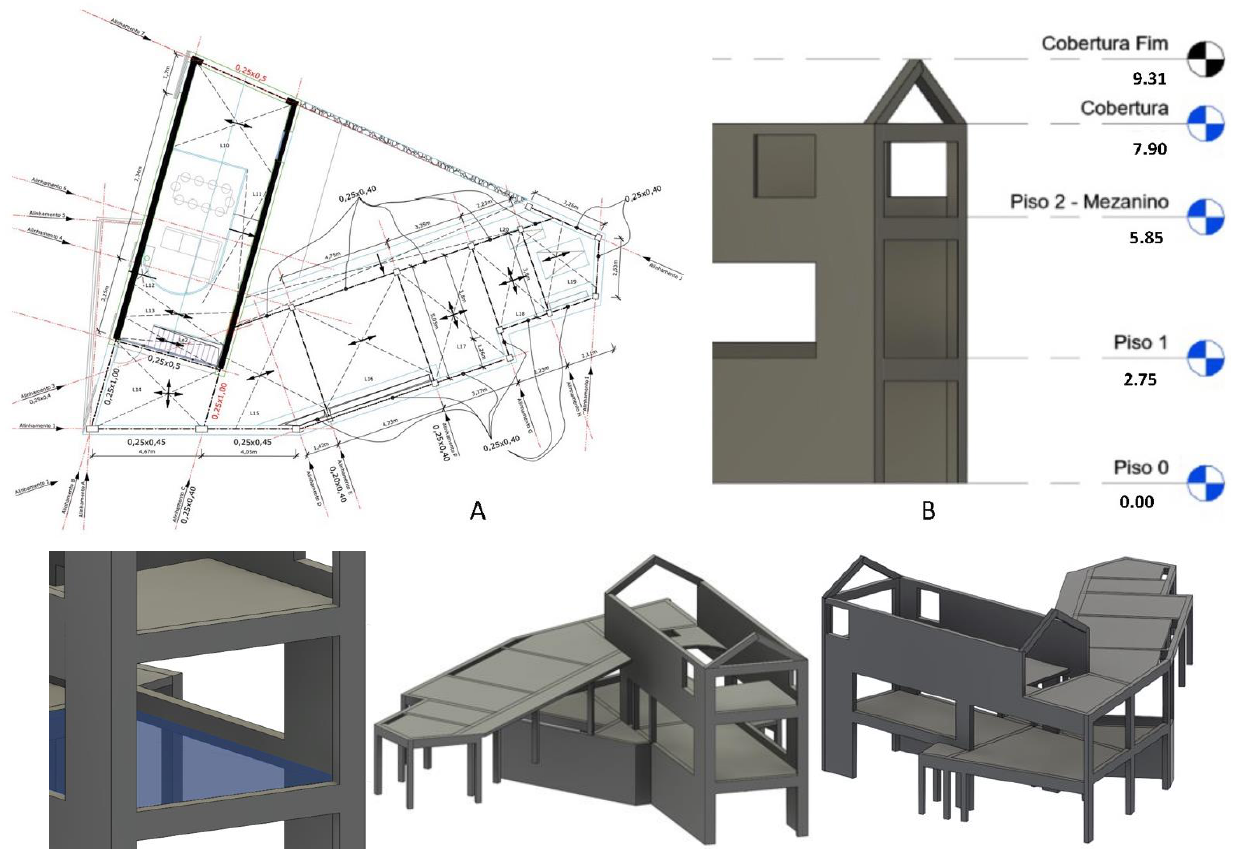
Figure 2. Imported CAD drawings (A ) and perspectives of the BIM model of structures created in Revit (B) . Revit ( B